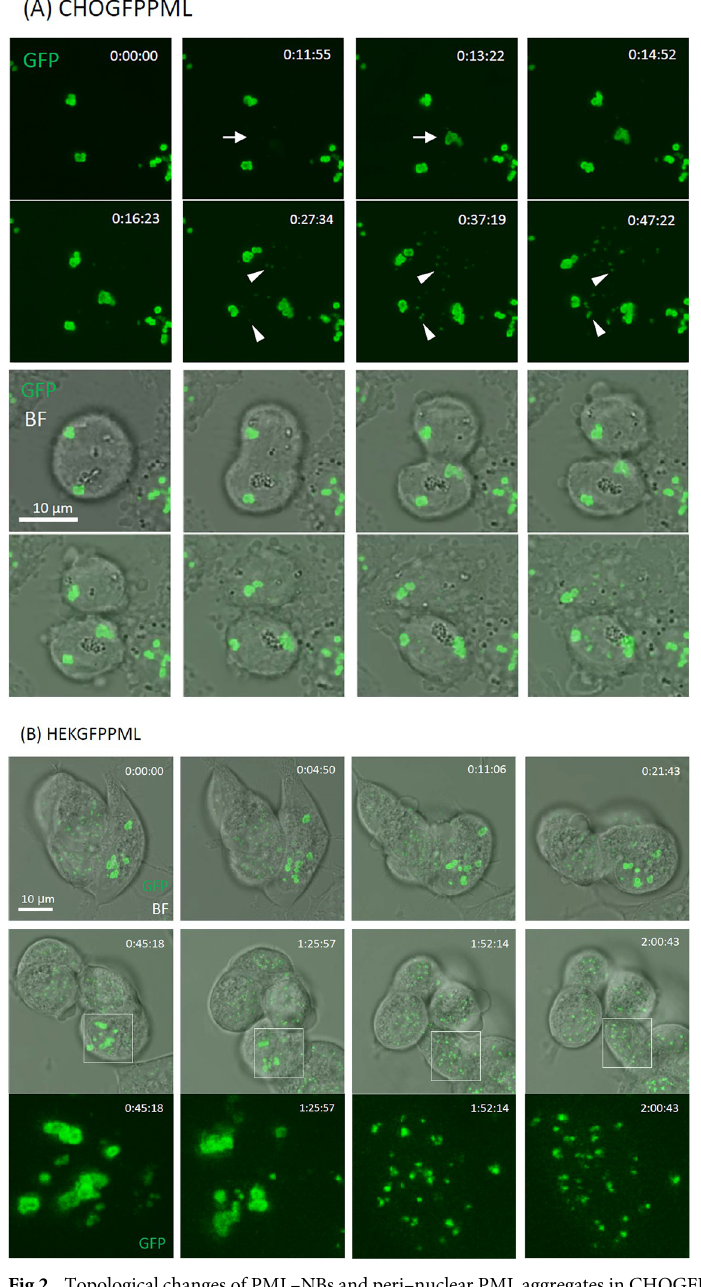
Fig 2. Topological changes of PML–NBs and peri–nuclear PML aggregates in CHOGFPPML (A) and HEKGFPPML cells (B). GFP live images were obtained by confocal laser scanning microscopy in z–stacking mode. (A) Time–lapsed images of CHOGFPPML cells were captured during cell division and spreading. The upper 8 panels show GFP images, and the lower 8 panels show overlaid images with the corresponding bright field (BF). The time counter is shown in the right upper corner of each GFP panel. Arrows show de novo appearance of a large peri–nuclear PML aggregate. The accretion of small GFP speckles began at 0:11:55 and the large toroidal PML aggregate was formed clearly after 1 min and 27 sec (at 0:13:22). Arrowheads show small nascent PML–NBs that appeared in daughter cells after cell division. (B) Time–lapsed images of HEKGFPPML cells were captured. The time counter is shown in the right upper corner of each panel. GFP fluorescence images in the boxed areas were enlarged and are shown in the bottom 4 panels. The toroidal PML–NBs were dissipated or dissolved (1:25:57), then were transformed into small granular dot–like PML–NBs (1:52:14) in the non–dividing